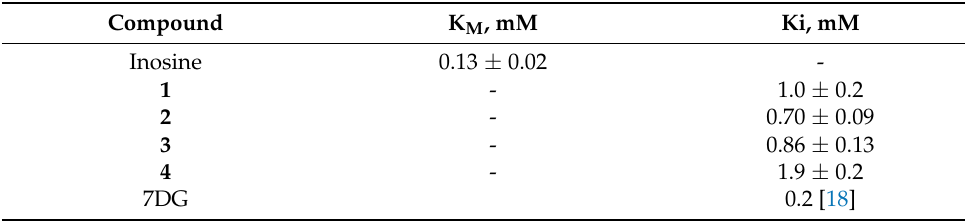
Table 1. Kinetic parameters of inosine phosphorolysis inhibition.